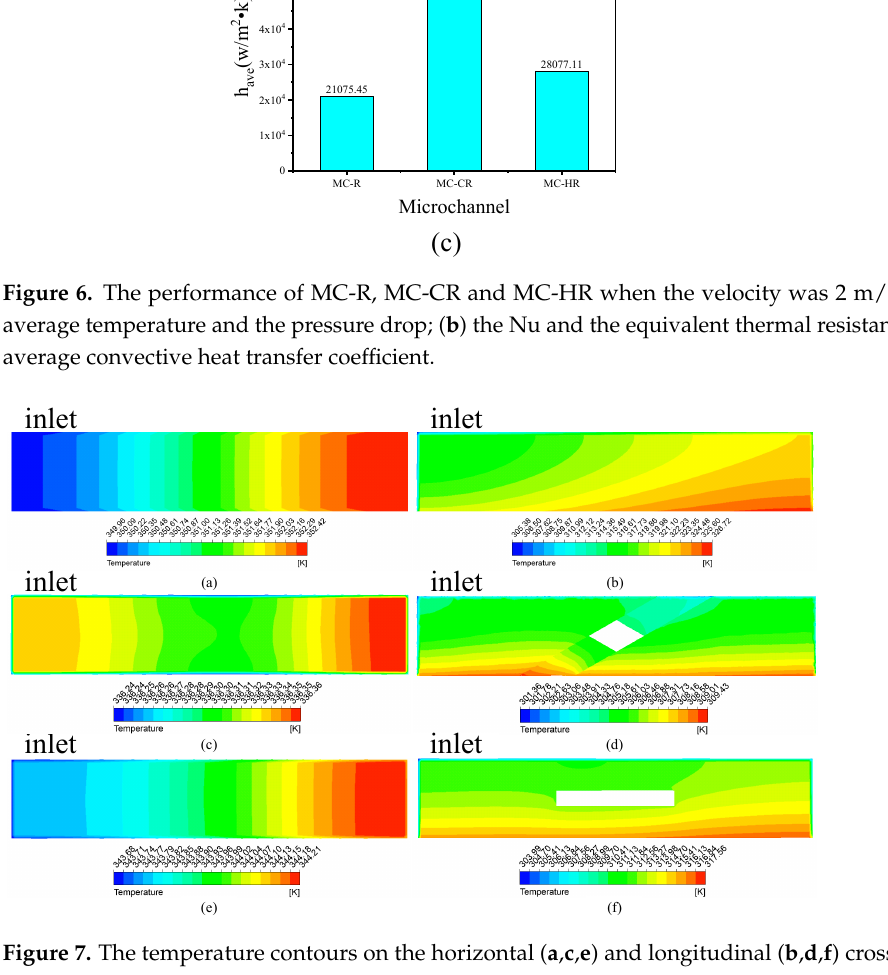
Figure 7. The temperature contours on the horizontal ( a , c , e ) and longitudinal ( b , d , f ) cross-sections: ( a , b ) MC-R; ( c , d ) MC-CR; ( e , f ) MC-HR. The thickness of the boundary layer ( δ ( x )) is defined as